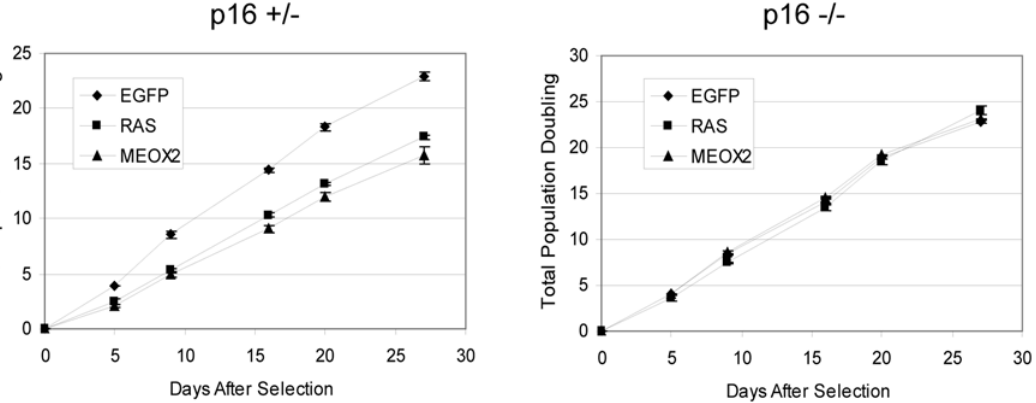
Figure 8. MEOX2-induced senescence requires p16INK4a. Early passage p16INK4a 2 / 2 (Leiden) or + / 2 (Foo3) fibroblasts were infected with retroviral particles and assayed for proliferation as in Figure 4. Mean values of three replicates are shown; error bars represent one standard